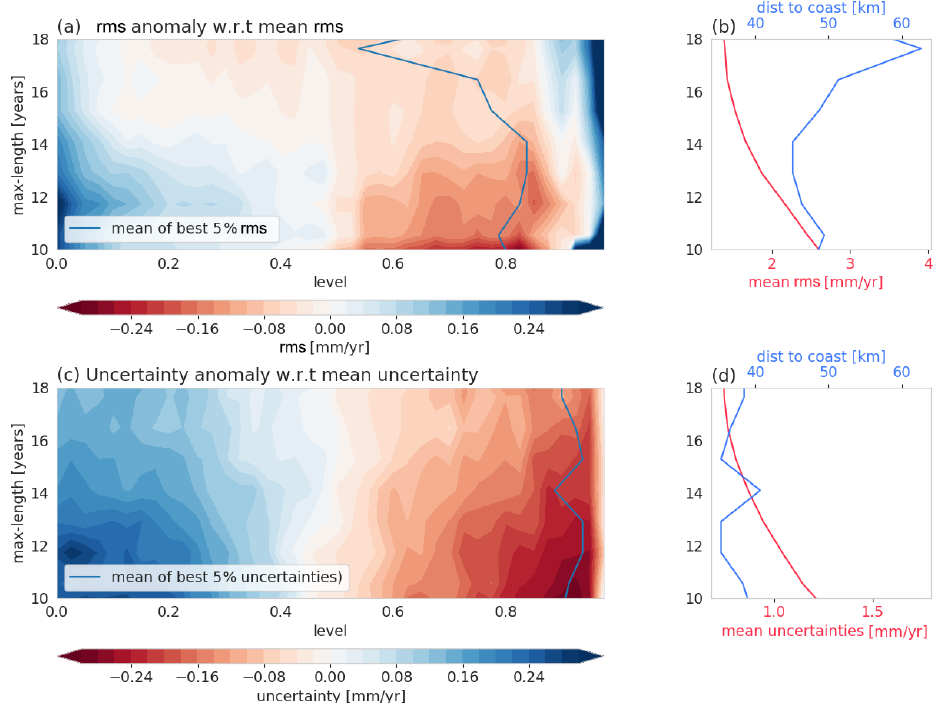
Figure 7. Time and space dependencies of trend uncertainty and accuracies: (a) evolution of the rms (cid:49) VLM anomaly (SAT–TG vs. GNSS trend) for subsets of ALES–GESLA–ZOI, depending on a relative threshold X ( x axis) and a maximum record length ( y axis). The rms (cid:49) VLM anomaly is defined as the departure from the mean rms (cid:49) VLM (shown in b ) averaged over all thresholds X for a specific maximum record length. In (b) we also show in blue the mean distance to the coast of the measurements, associated with the average of the best 5% ZOI levels per timescale, shown in (a) . (c, d) Same as (a, b) but for